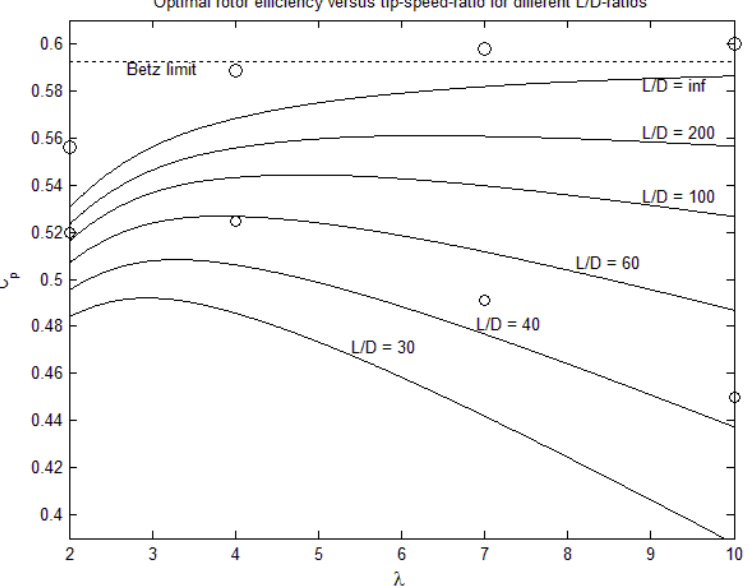
Figure 4. Optimal rotor averaged power efficiency versus TSR for a range of airfoil glide-numbers computed with the new BEM. No tip losses are included. All the (cid:1829) are computed with the thrust coefficient value of (cid:1829) circular markers are validating HAWT actuator disk (AD) results for infinite L / D . The four small circular markers are HAWT AD results for L / D = 40, see Section 3 for discussion of the BEM-AD